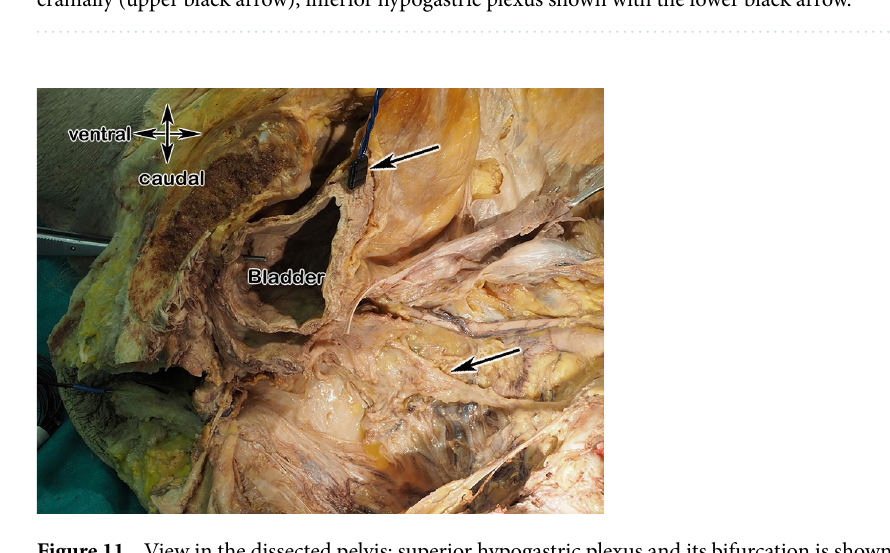
Figure 11. View in the dissected pelvis: superior hypogastric plexus and its bifurcation is shown (black